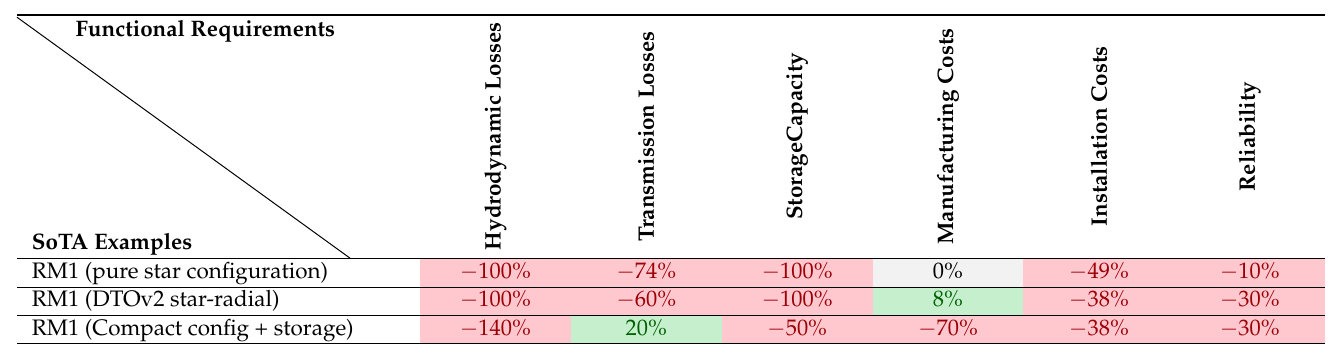
Table 10. Example showing relative deviation of each SoTA functional requirement from the set targets (ideal values) in Table 9. Red, green and grey shading used to highlight underachieved, exceeding or achieved SoTA functional requirements, respectively.